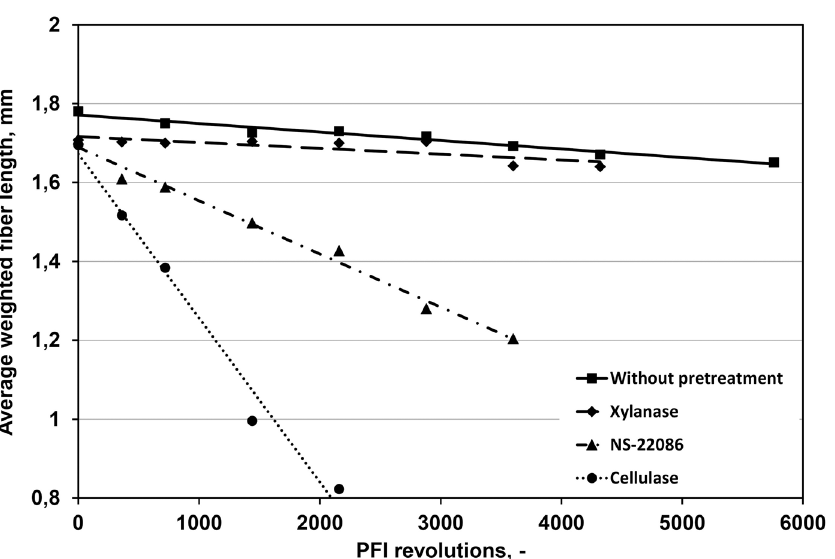
Fig 2. The effect of enzyme preparations and number of PFI mill revolutions on the weighted average fiber